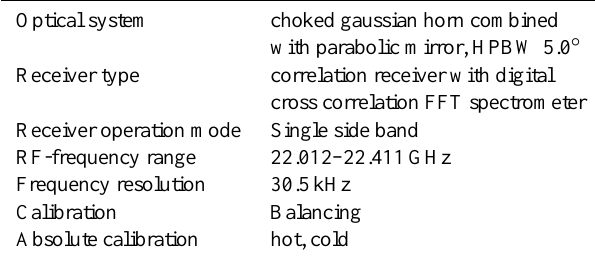
Fig. 3. Optical system of MIAWARA-C.